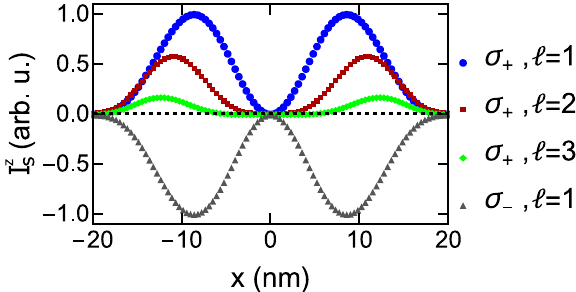
Fig. 7 Spatial pro fi le of the time-integrated out-of-plane ISHE signal. Twisted magnon waves for different topological charges and chiralities are generated in the NiO waveguide. The resulting z - component of the spin accumulation according to the ISHE is calculated via I s (cid:5) n ´ ∂ t n